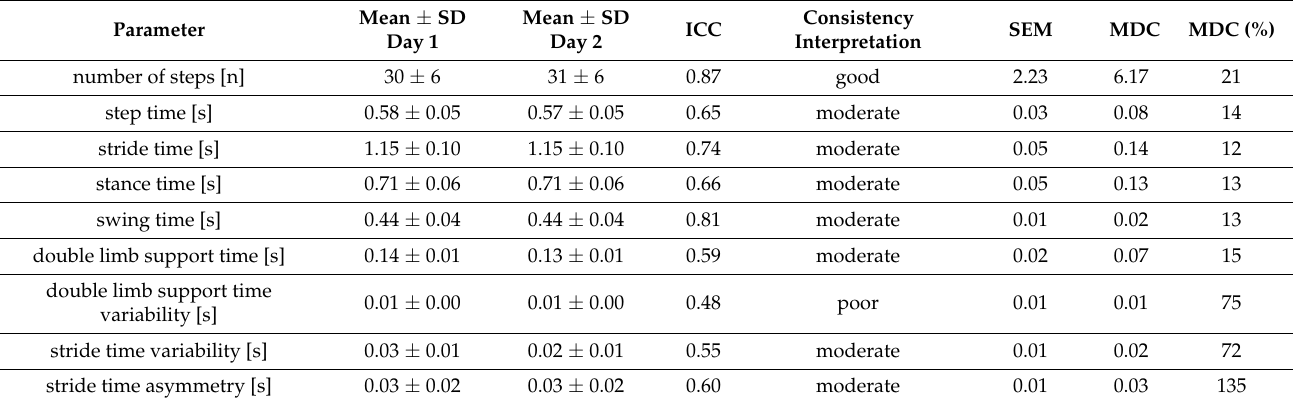
Table 3. Reliability and minimal detectable change: 20 m walking distance (steady